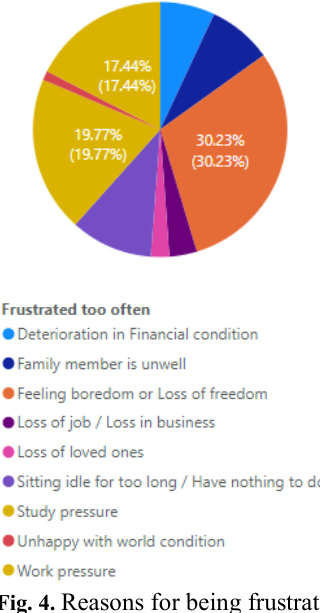
Fig. 4. Reasons for being frustrated Finding 4: Professionals from which sector faced financial